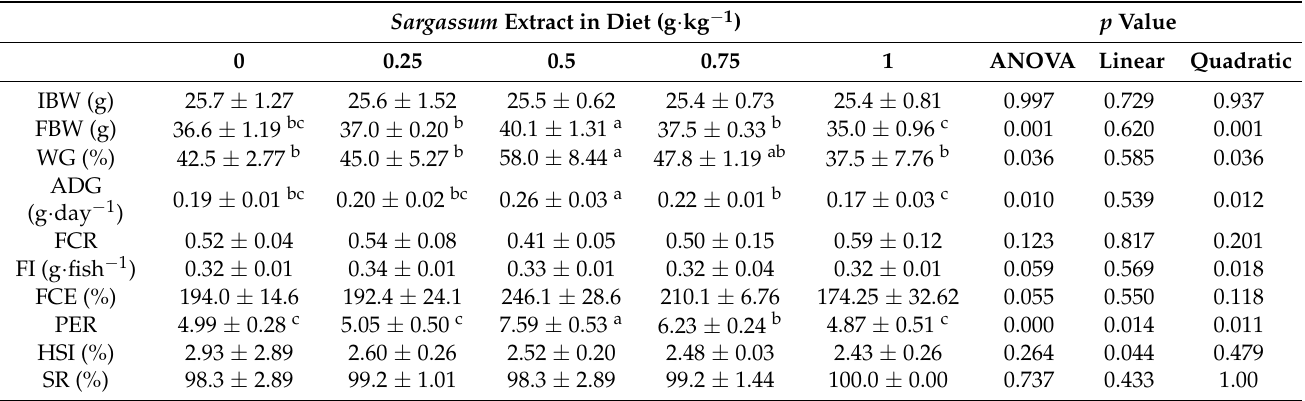
Table 3. Growth performance, feed utilization, and survival rate of spotted scat fed the experimental diets for 8